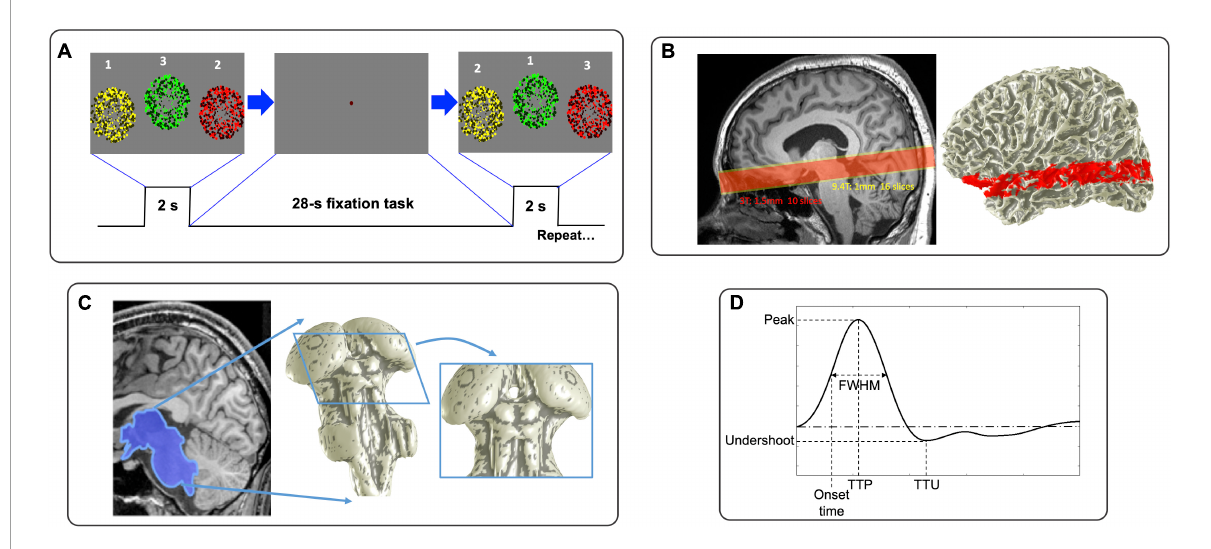
FIGURE1 (A) Visual stimulus consisted of rapid sequential presentations of circular regions of flickering dots. (B) Functional prescriptions for 9.4T (yellow) and 3T (red). (C) Example of 3D segmentation of subcortical areas. (D) Graphical depiction of HRF